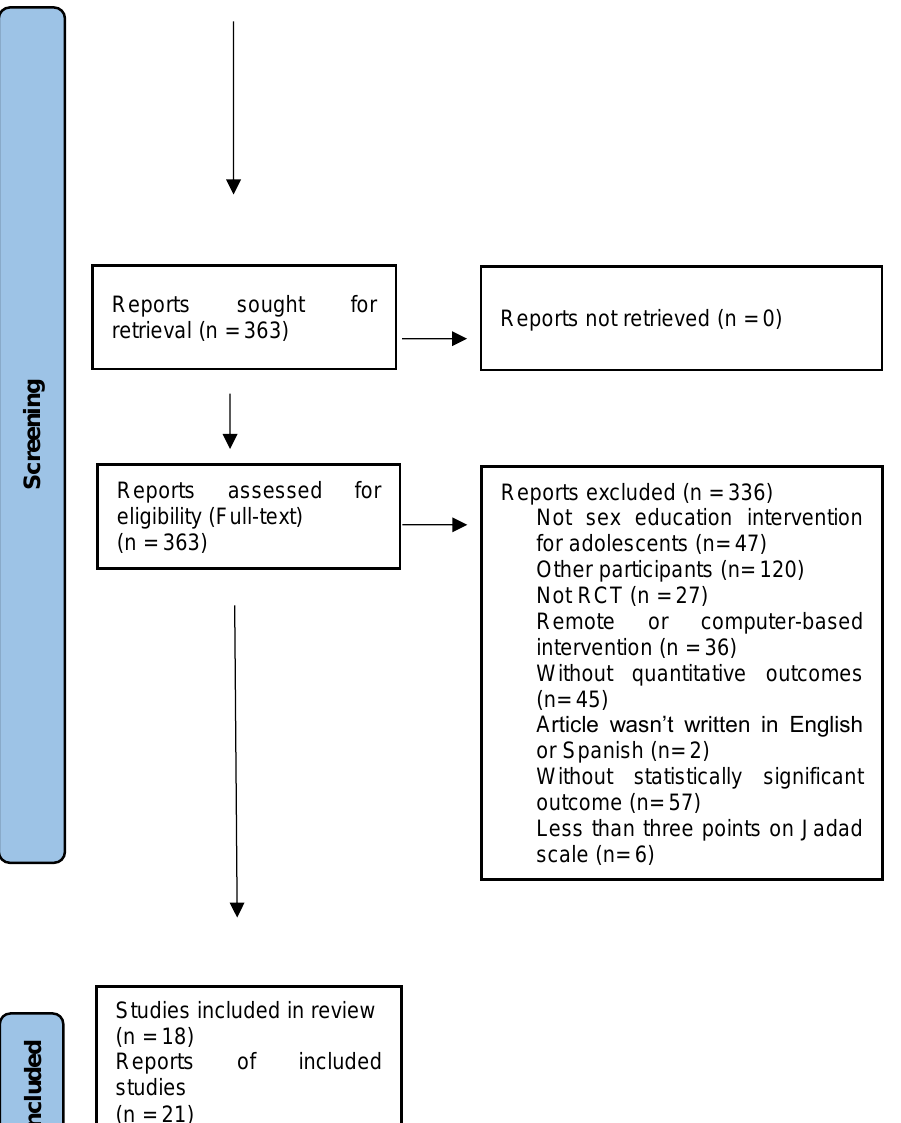
Figure 1. Preferred Reporting Items for Systematic Reviews and Meta-analyses (PRISMA) flow diagram study selection and inclusion process.